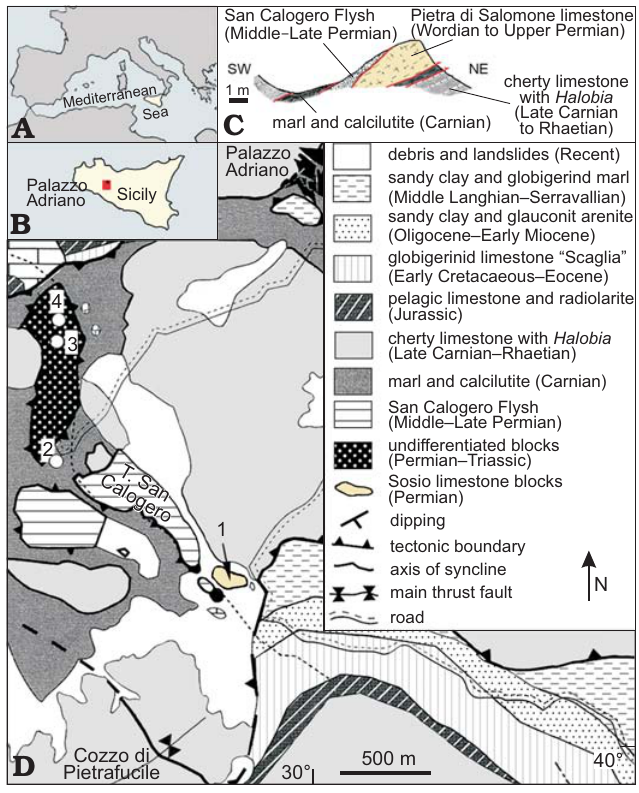
Fig. 1. Location of the study area in Mediterranean ( A ) and Sicily ( B ). Section across the Torrente San Calogero and the Pietra di Salomone block ( C ), modified from Flügel et al. 1984. Geological map of the Palazzo Adri- ano area ( D ), showing the location of the Pietra di Salomone block (mod- ified from Di Stefano and Gullo 1997). 1, Pietra di Salomone